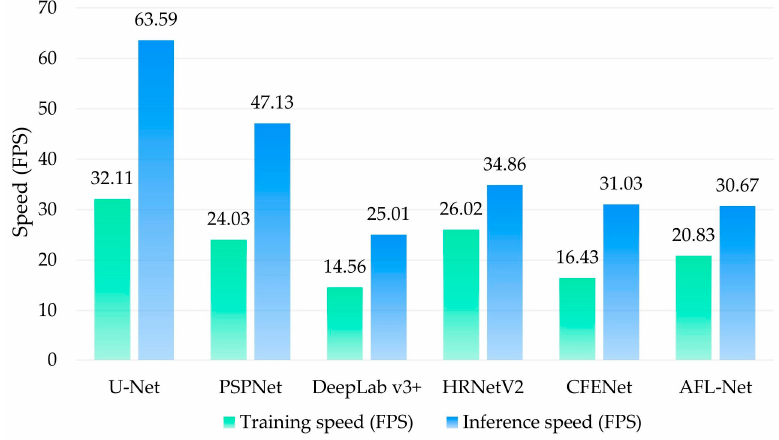
Figure 17. Comparison of the training and inference speeds of the selected models.